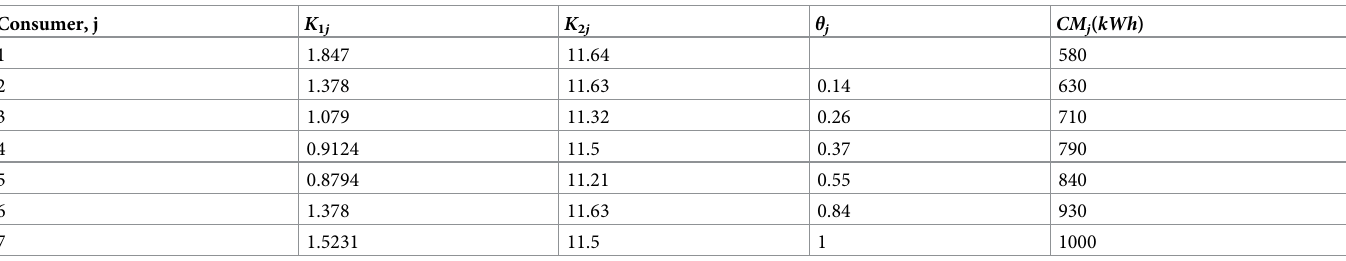
Table 6. Cost coefficients, consumer classification and limit of curtail power to consumers—case 2 [8]. Consumer,